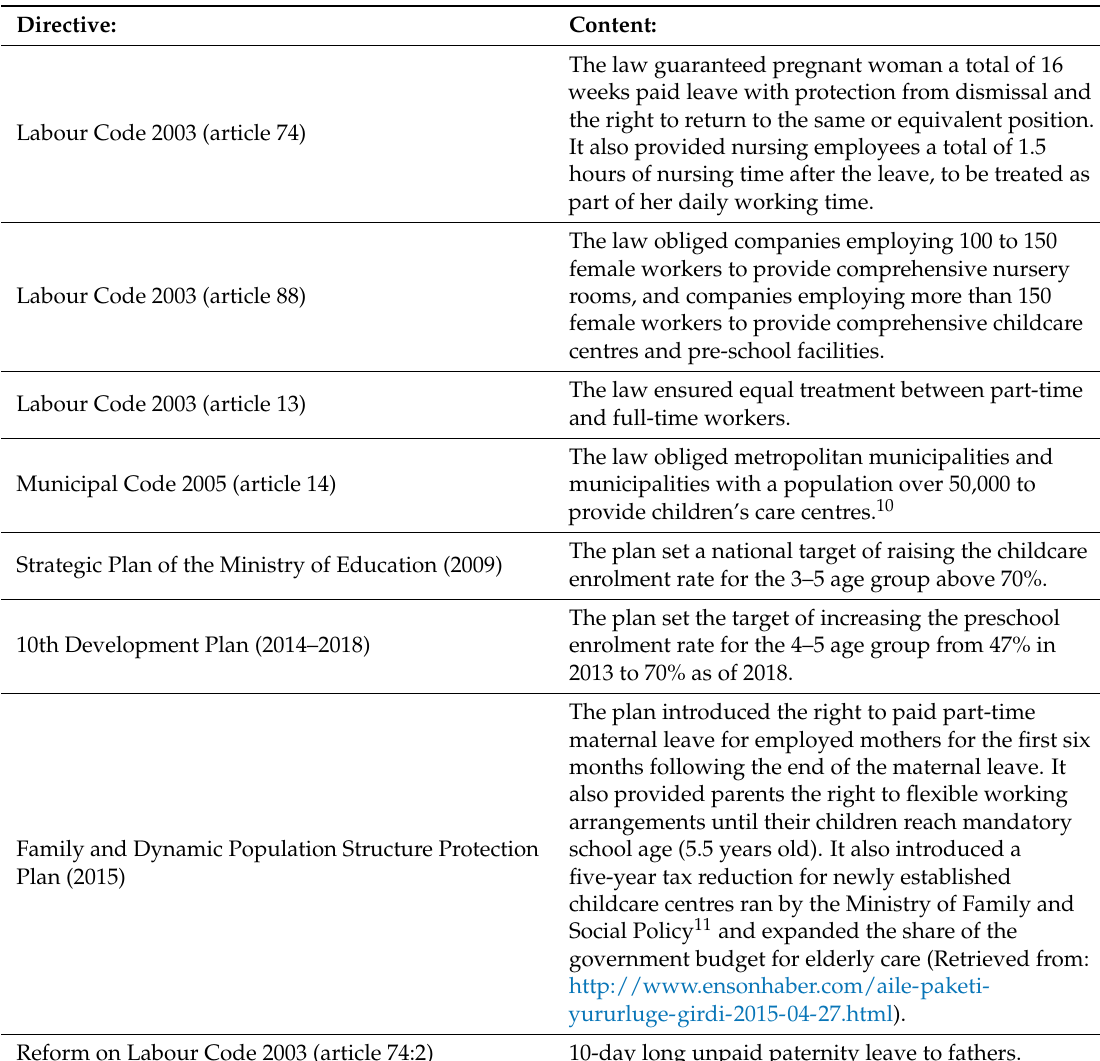
Table 2. Europeanisation of work and family life reconciliation policies in